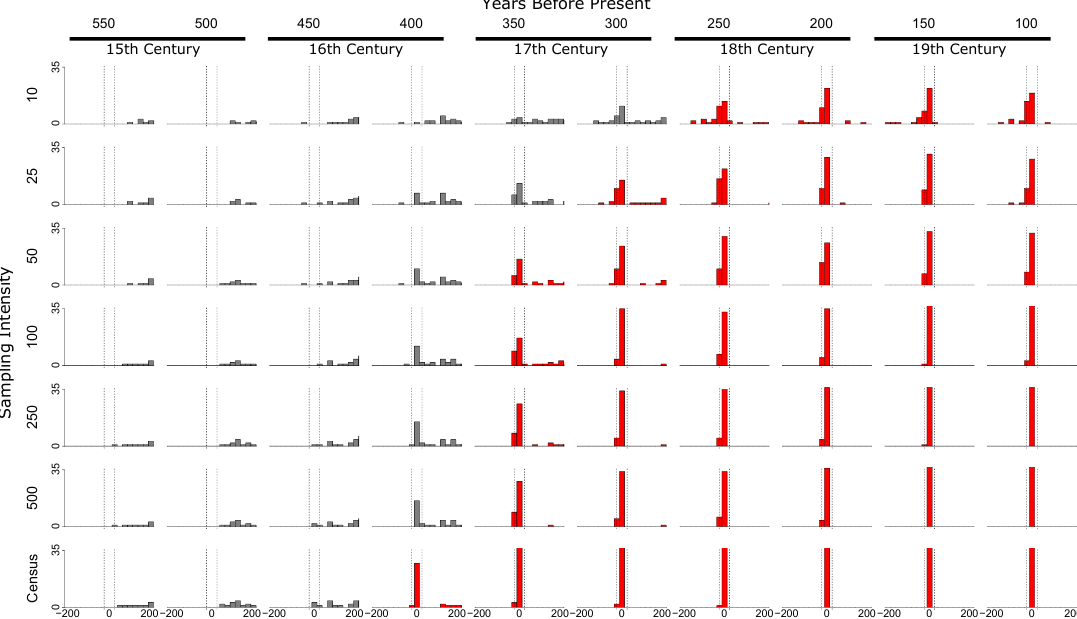
Figure 4. Histograms of inferred regime shifts from moving t -tests relative to the known regime shift date in Scenario 1 (shift from annual patch burning to bidecadal spreading fires). Columns are for the date before the end of the model run when the forced regime shift happened. Corresponding centuries in the real world are shown for comparison to fire-scar studies. Rows are for di ff erent sampling intensities. Red histograms denote scenarios where the majority of the regime shift simulations ( > 20 model runs) were accurately identified. Note that recent regime shifts are accurately predicted at all sampling intensities. Greater sampling intensities are needed to identify regime shifts further in the past but even census level sampling does not correctly identify regime shifts that are beyond the typical lifespan of the modeled tree (400 years, see Appendix